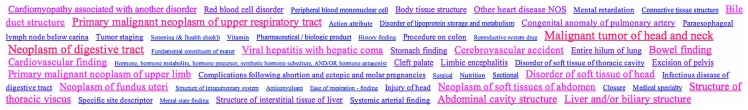
Tag cloud output: An example for the annotations of grants from FY1981 using SNOMEDCT.Blue denotes low-frequency terms and red denotes highly frequent terms. Many concepts, such as “neoplasm of digestive tract”, occur at high frequencies in most years, possibly denoting the constant focus on cancer research. An appropriate background term frequency distribution is necessary to determine significance of the high frequency.